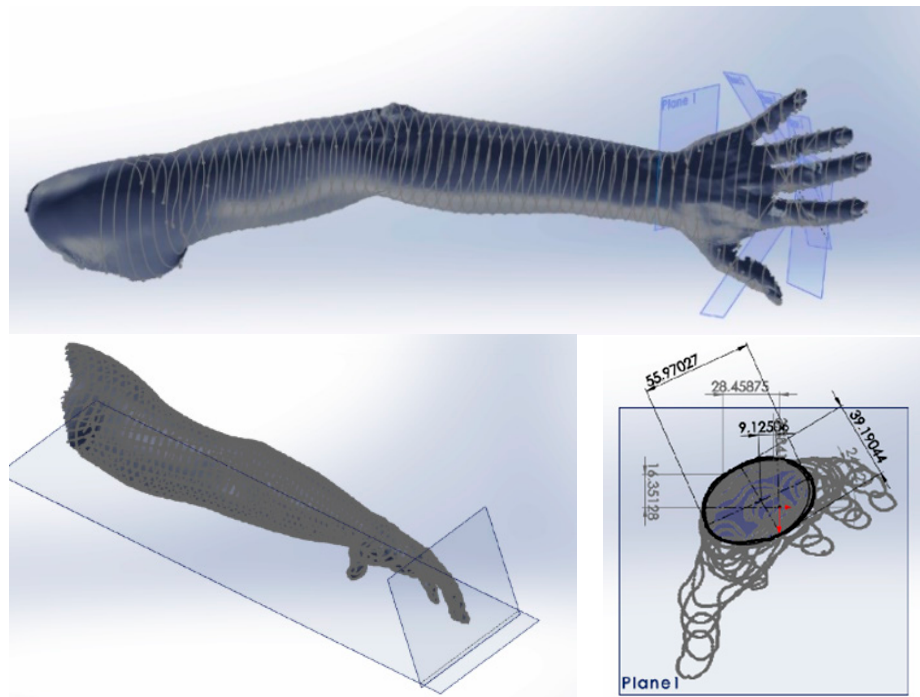
Figure 4. Reverse engineered real upper limb surface—transversal plane contour characteristics